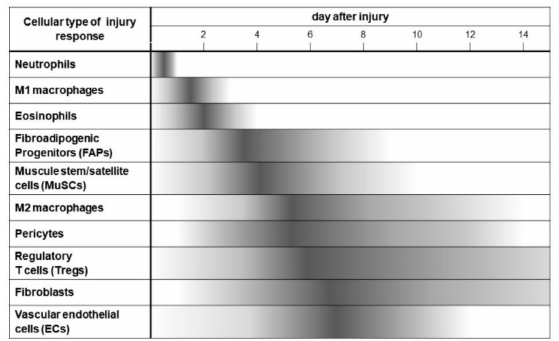
Figure 2. The cellular dynamics during muscle regeneration after